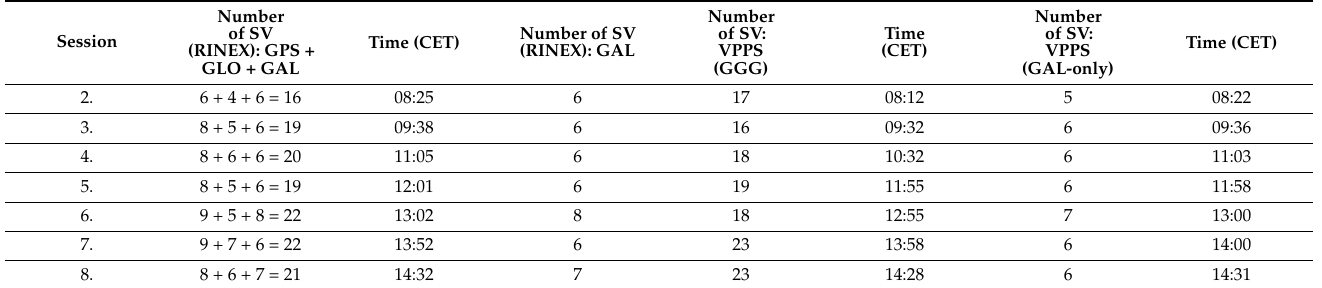
Table 4. Comparison of the number of satellites contained in the RINEX observation files (static) with number of satellites included in VPPS solutions (GGG and